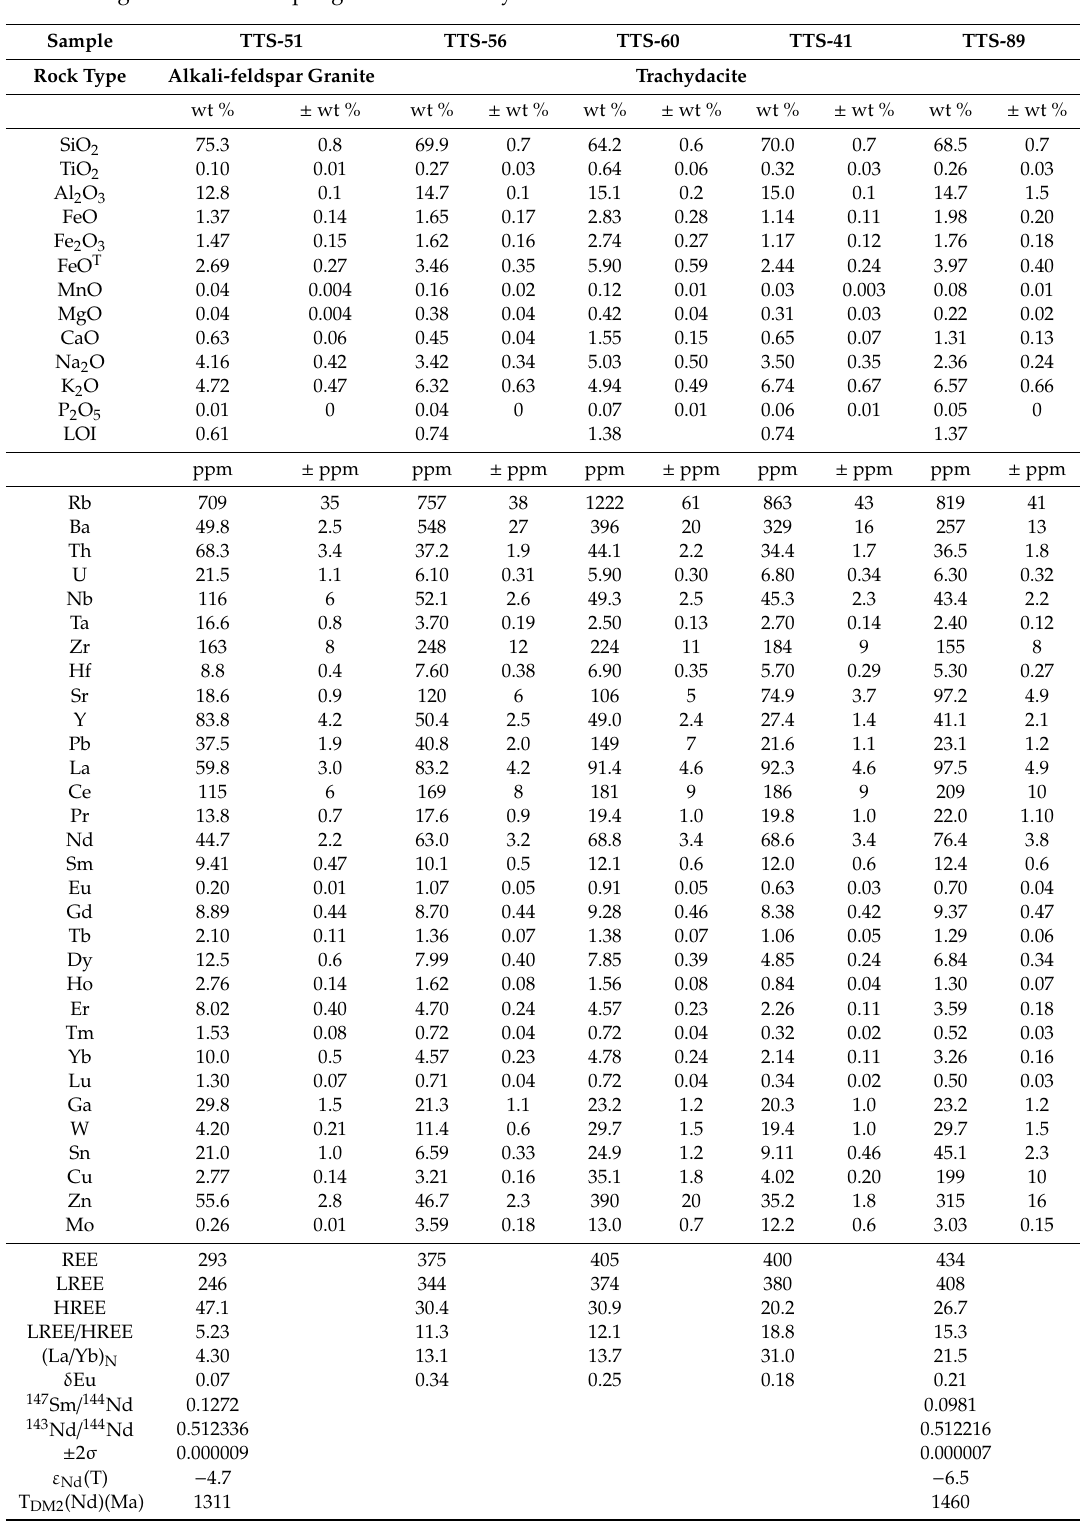
Table 3. Major (wt%), trace element (ppm), Nd isotope compositions and T DM2 (Nd) ages of the Tiantangshan alkali-feldspar granite and trachydacite. Sample Rock